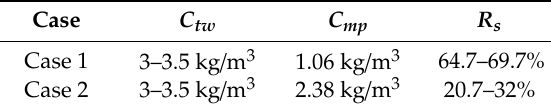
Table 1. The sediment removal rate of two cases.